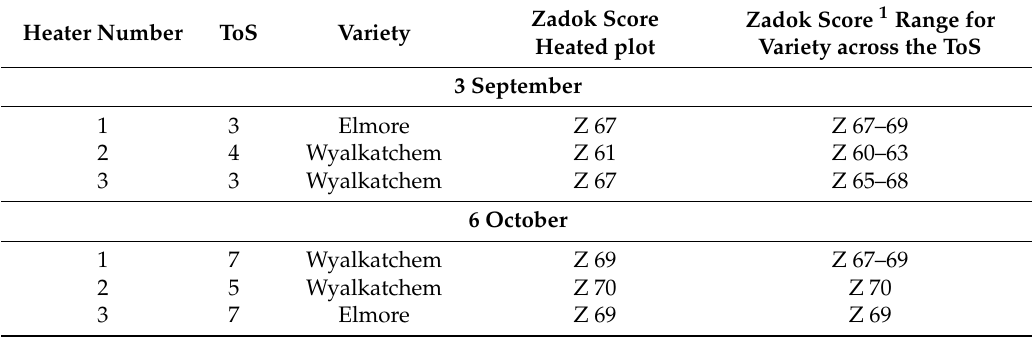
Table 2. Zadok scores for heated plots and whole ToS in 2017.